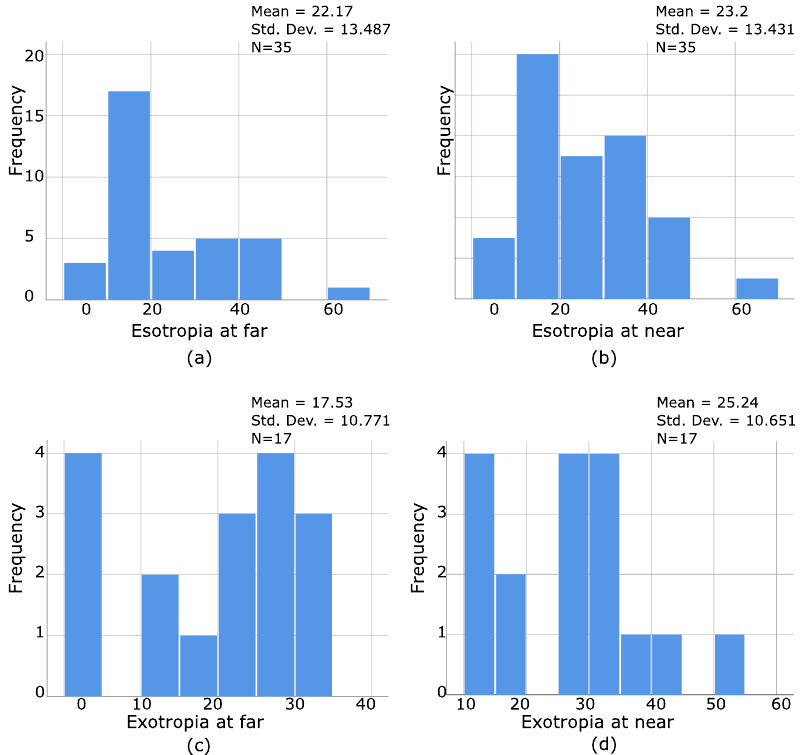
Figure 7. ( a – d ) Represents the distribution of frequencies of type and magnitude of deviation in stereoblind PS. As seen by ( a , b ), patients with ET have a higher probability of being stereoblind. Addi- tionally, a greater amount of deviation is necessary for patients with exotropia to be stereoblind ( c , d ). The distribution of the amount of visual acuity for each eye at both distances for our stereoblind population was graphically presented as well, as seen by Figure 8a–d, where even strabismic patients without amblyopia (VA of 0.0 and 0.1 logMar) can be stereoblind, which confirms that the amount of visual acuity does not predict the presence or absence of stereopsis. the amount of hyperopia and visual acuity at far/near, where the results were statistically insignificant. For OD, p = 0.08/0.1 while for OI, p = 0.83/0.6, respectively.